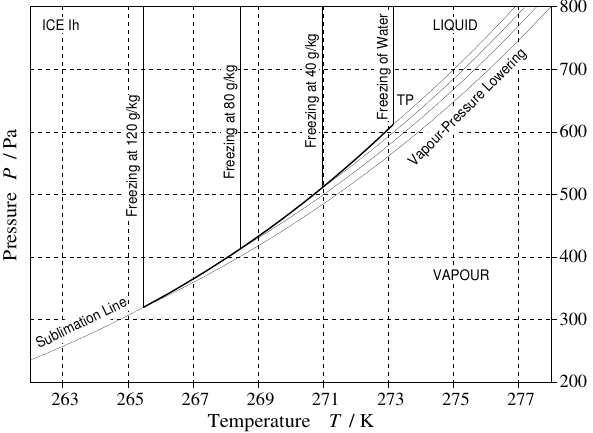
Fig. 7: Temperature-pressure phase diagram of seawater in the vicinity of the triple point. At different salinities, the triple point (TP), i.e. the equilibrium between liquid seawater, ice and vapour is displaced along the sublimation line (in bold) of the ice-vapour equilibrium. Note that the triple-point pressure can change by a factor of 2 while the vapour-pressure lowering at constant temperature is only of order 10% or less.